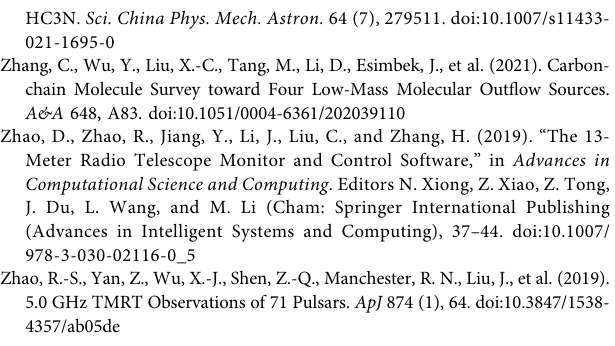
Figure 7 . We may also need to open the container ’ s terminal to execute some commands. For example, part B of Figure 7 to see if the name con fi guration of the database is